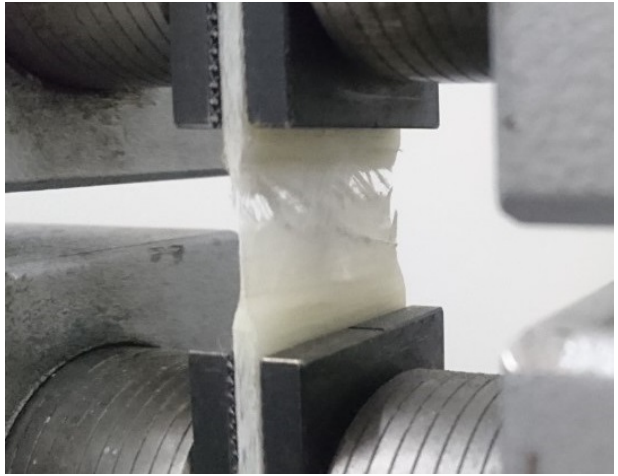
Figure 18. Failure of flexure hinge specimen at tensile test.